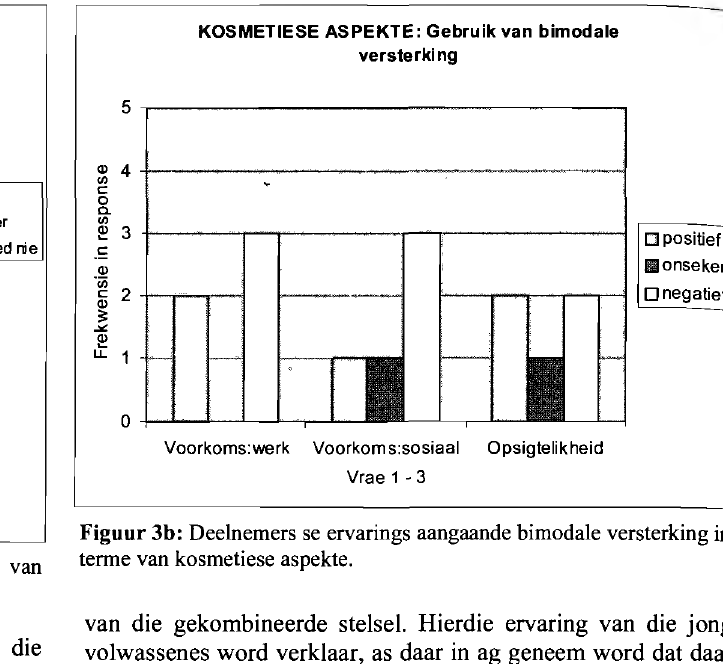
Figuur 2b: Response van deelnemers aangaande die gebruik van bimodale versterking in terme van kommunikasie fiinksionering. Dit is dus duidelik dat die jong volwassenes oor die algemeen ‘n positiewe ervaring aangaande bimodale versterk­ ing vertoon in terme van kommunikasie fiinksionering. Die jong volwassene se voile kommunikasie potensiaal word dus beskikbaar gestel deur die gebruik van bimodale versterking (Armstrong et.al, 1997).